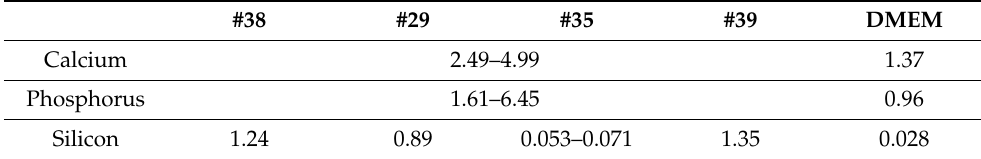
Table 2. Chronic ions release 1–5 days (mM).